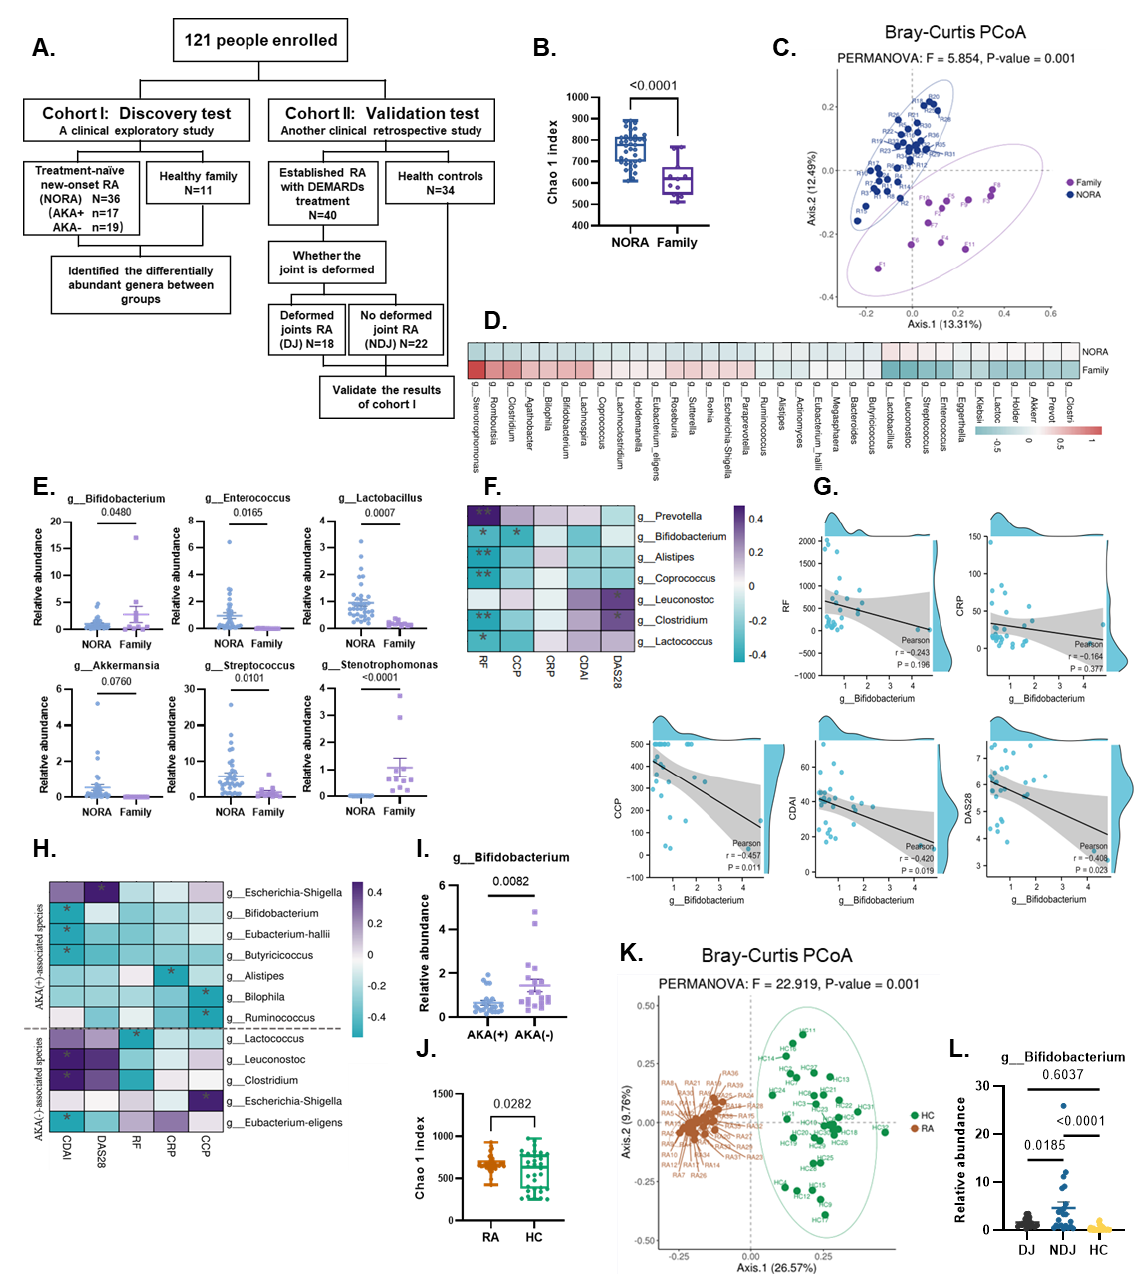
Figure 1. Gut microbial composition at the genus level and clinical relevance in RA patients and healthy controls of two cohorts. ( A ) A flow diagram depicting the enrollment and analysis of RA patients and healthy individuals. ( B ) Chao 1 index of the NORA cohort was significantly higher in RA patients compared to their relatives ( p < 0.001). ( C ) Bray–Curtis-based PCoA analysis revealed significant differences in microbial community structure between the patients and their family members, with fewer individual differences in the NORA group. ( D ) The 34 highly expressed differential genera identified by the quasi-paired cohort method (Wilcoxon signed-rank test) for each subject. The color bar indicates the Z score-normalized abundance (scaled by row); green and red names represent low and high expression, respectively. ( E ) Relative abundance of 6 highly expressed differential genera. Bifidobacterium was found to be significantly depleted in RA patients. ( F ) List